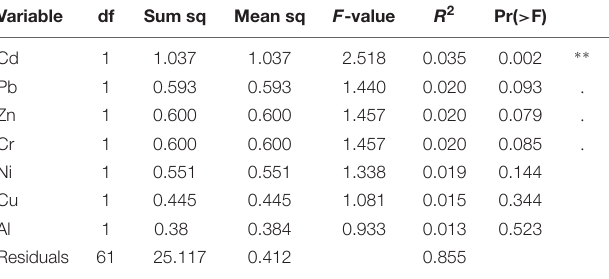
part of OTUs were shared between healthy and RDBS